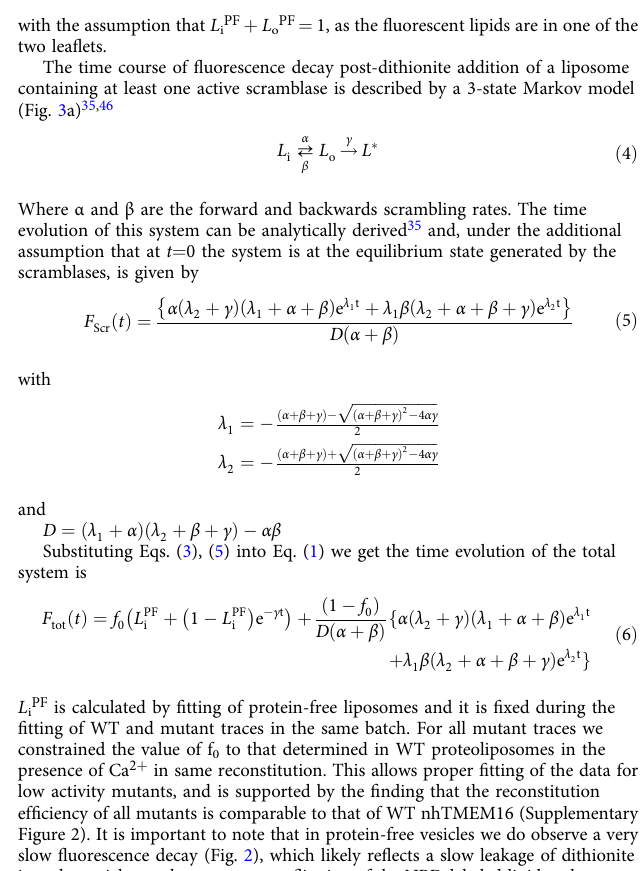
phosphoethanolamine (NBD-PE) was additionally added to the lipid mixture. Liposomes were prepared from a 2.25:0.75:1 mixture of 1-palmitoyl-2-oleoyl- sn - glycero-3-phosphoethanolamine (POPE): 1-palmitoyl-2-oleoyl- sn -glycero-3-phos- pho-(1 ′ -rac-glycerol) (POPG) and L- α -Phosphatidylcholine (Egg, Chicken-60%). All lipids were purchased from Avanti Polar Lipids. Lipids were dissolved in reconstitution buffer (300mM KCl, 50mM HEPES, pH 7.4) in the presence of 35 mM 3-((3-cholamidopropyl) dimethylammonio)-1-propanesulfonate (CHAPS, Pierce). After completely dissolving lipids, the puri fi ed protein was added to the